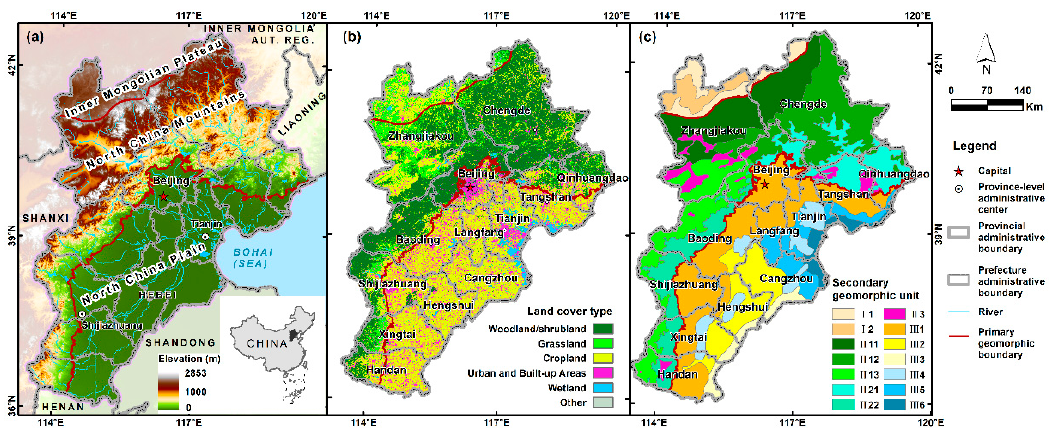
Figure 1. ( a ) Location and elevation map. ( b ) Land cover type map. ( c ) Geomorphic unit division, and secondary geomorphic units, including Plateau Hills (I 1 ), High Plain (I 2 ), Mountain-Yinshan Eastern Section ( Ⅱ 11 ), Mountain-Yanshan Section ( Ⅱ 12 ), Mountain-Taihang Section ( Ⅱ 13 ), Hilly Yanshan Section ( Ⅱ 21 ), Hilly Taihang Section ( Ⅱ 22 ), Mountain Basin ( Ⅱ 3 ), Alluvial-Proluvial Fan ( Ⅲ 1 ), Flood Plain ( Ⅲ 2 ), Yellow River Floodplain ( Ⅲ 3 ), Depression ( Ⅲ 4 ), Alluvial and Coastal Plain ( Ⅲ 5 ), and Marine Plain ( Ⅲ 6 ).